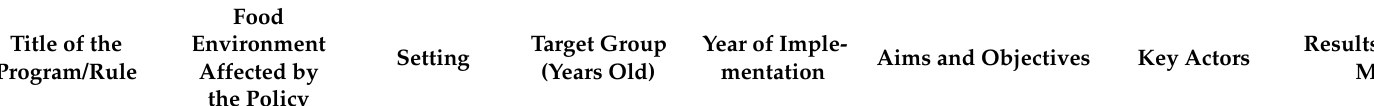
Table 1. Characteristics of food environment policies in kindergartens and schools in